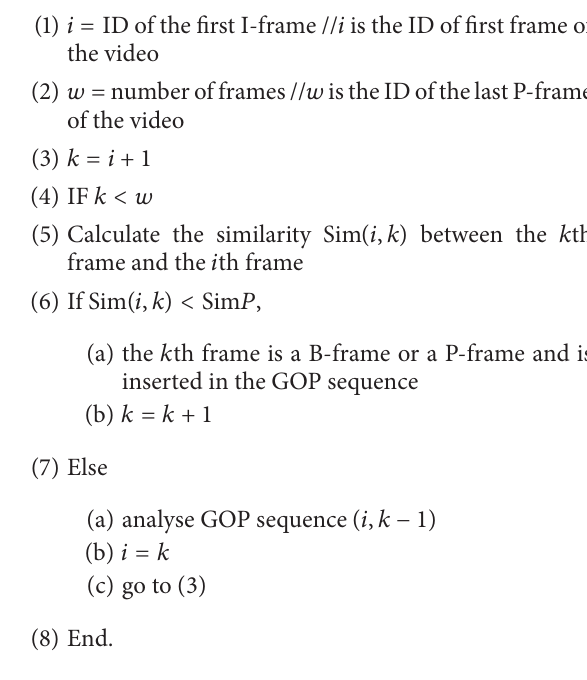
Algorithm 1 (analyze GOP sequence (ID1, ID2)). Pseudo- code for determining a GOP sequence